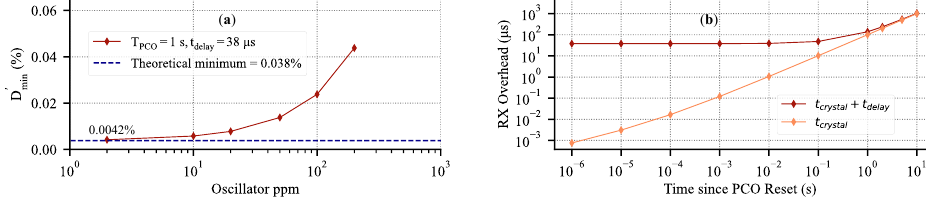
Figure 14. Simulated duty-cycle limits in a 50-node network randomly distributed on a 100m square grid. ( a ) D (cid:48) vs. oscillator stability; values approach theoretical minimum for a near-perfect crystal. min ( b ) RX window size overhead to receive the syncword assuming 50 ppm crystal with RMS jitter of 25ps. Notably after 1s, t delay becomes negligible and crystal non-ideality limits the minimum